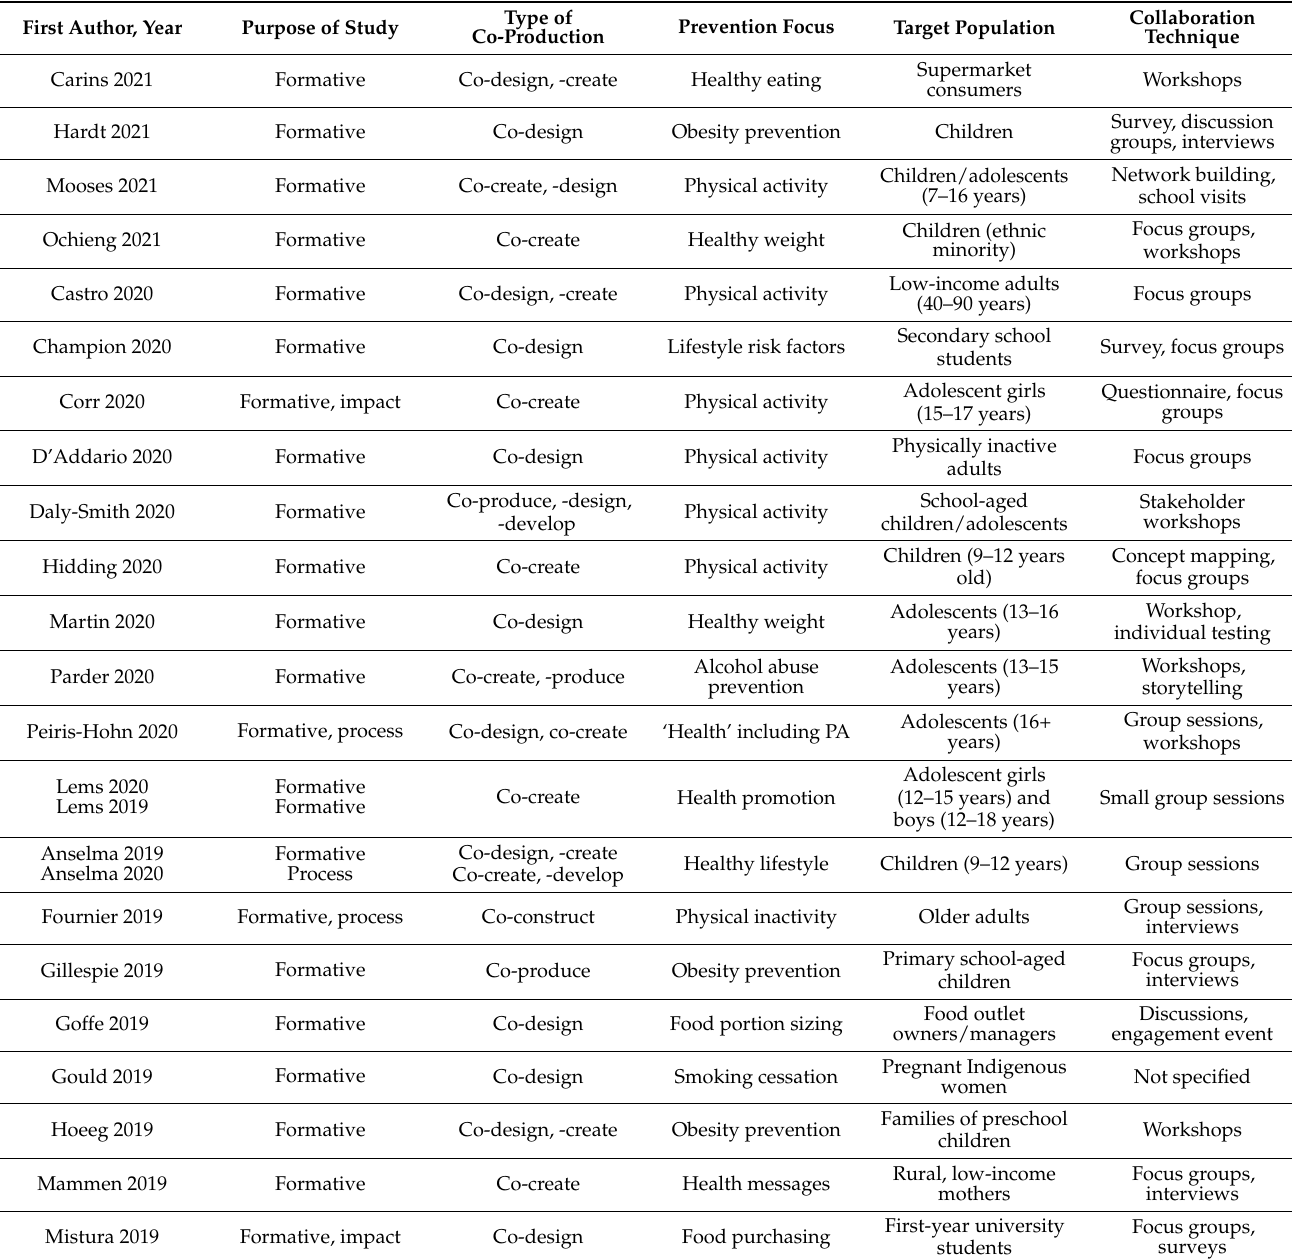
Table 1. Processes used to facilitate input from stakeholders during